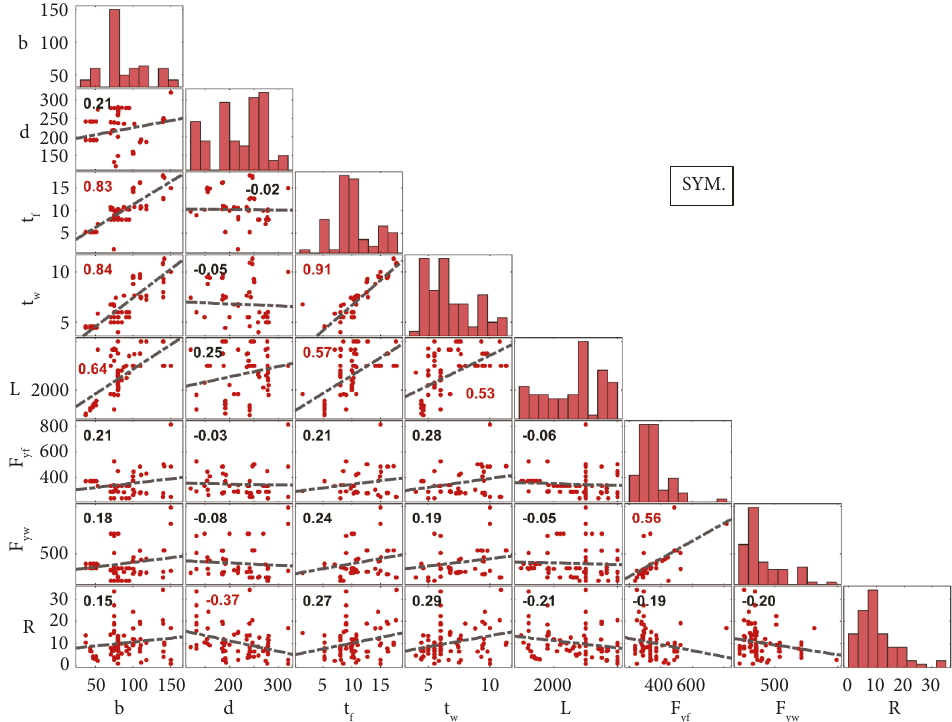
Figure 4: The distribution chart and correlation between input and output parameters considered in this study.